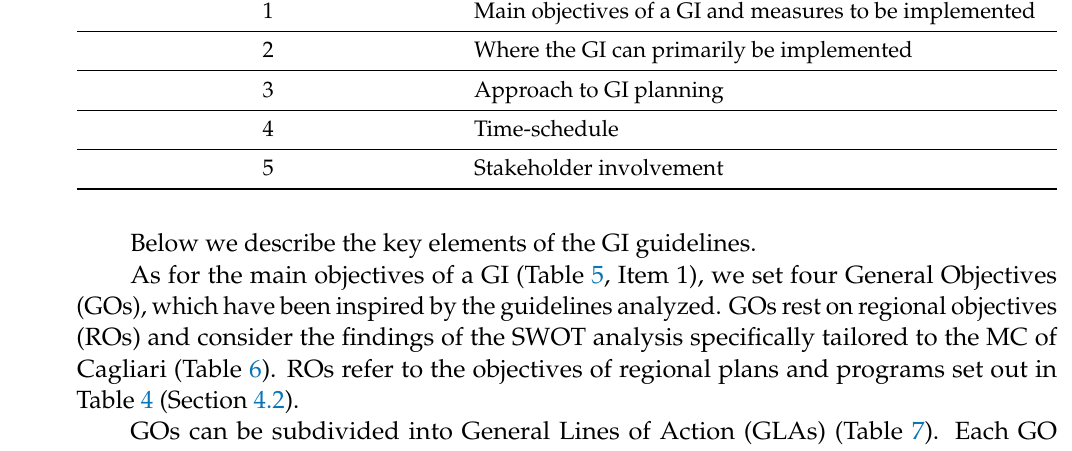
Table 5. The structure of the GI guidelines for the Metropolitan City of Cagliari. Item